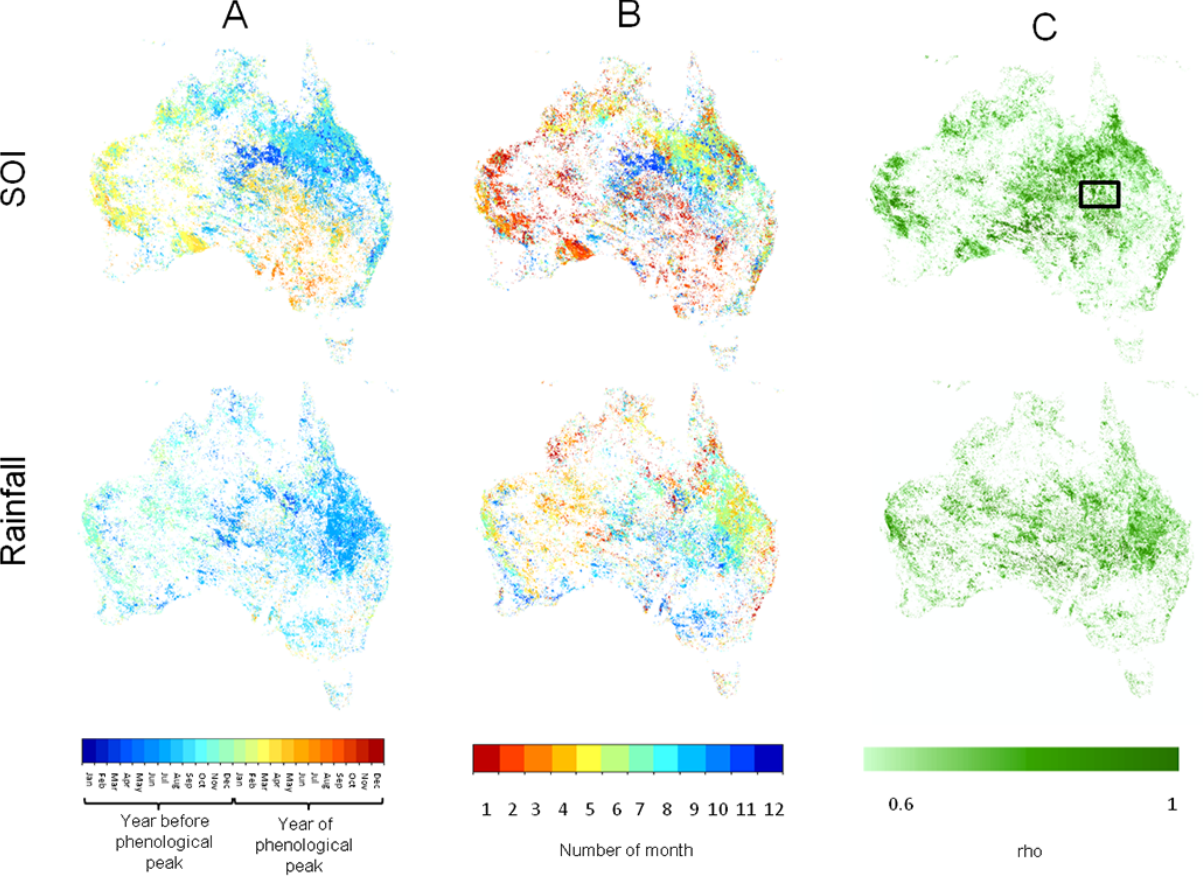
Figure 8. Statistically significant relationships between monthly SOI and phenological cycle peak magnitude (top row) and monthly rainfall and phenological cycle peak magnitude (bottom row). (a) SOI and rainfall month most significantly correlated with peak magnitude. (b) Lead time of SOI and rainfall month relative to phenological peak and (c) Spearman’s rho. Areas with p > 0.05 shown in white. The black box in the top-right panel marks the extent of the area shown in Fig. 9, centered on the Cooper Creek floodplain in interior eastern